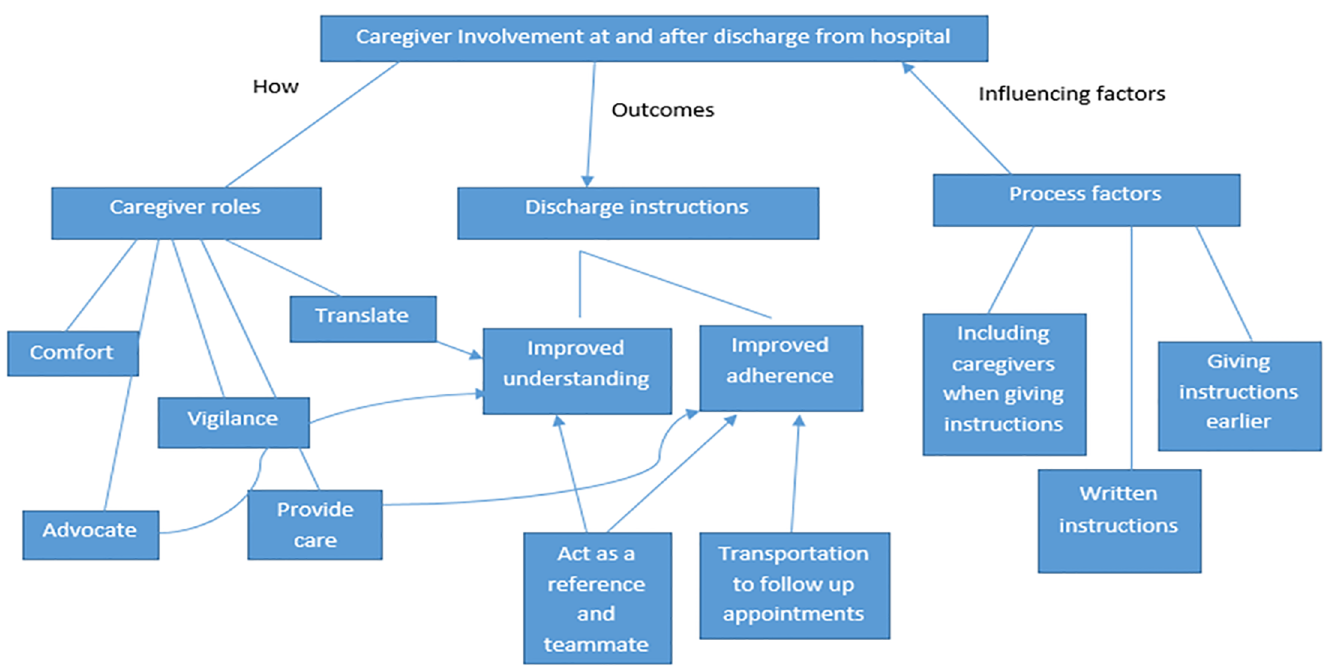
Fig 1. Themes related to caregiver involvement at and after the transition from hospital to home.